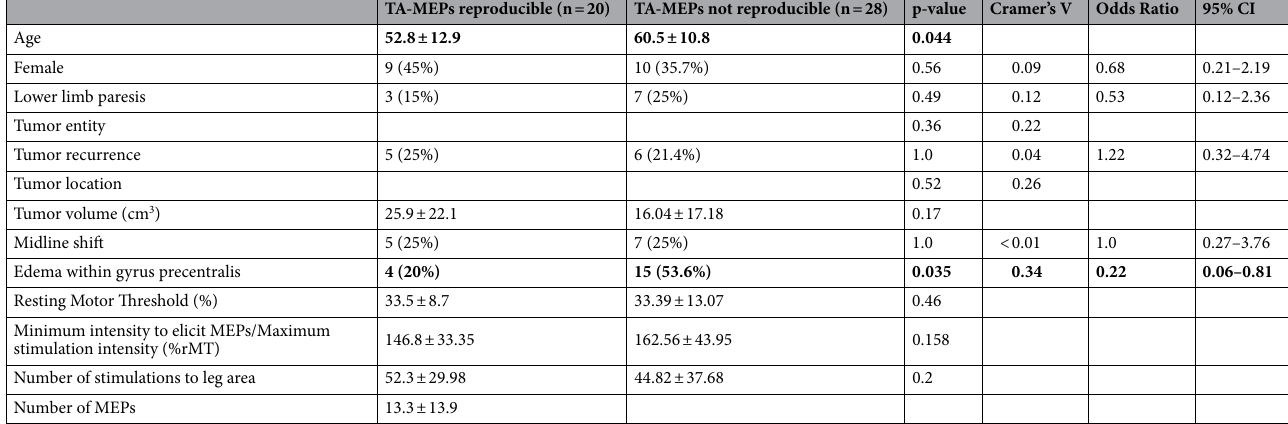
Table 2. Comparison of patients with reproducible leg-MEPs and patients without reproducible leg-MEPs. For continuous variables, means and standard deviations are displayed. Significant values are in bold.